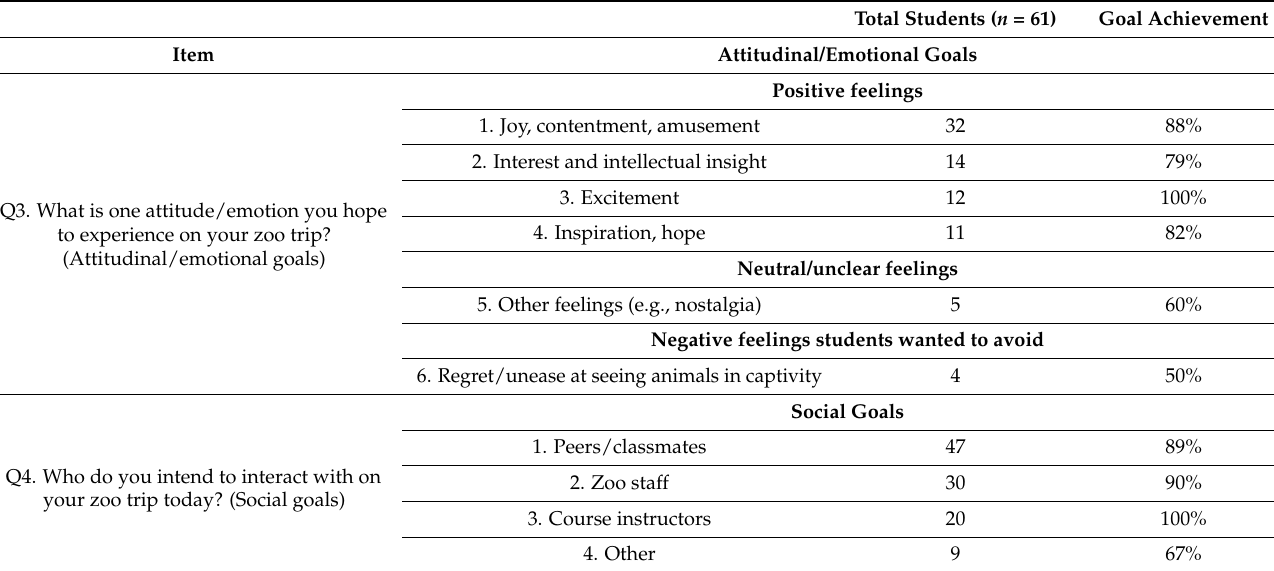
Table 3. Emerging themes for Questions 3 and 4 on the survey, number of students citing each theme, and percent goal achievement for each theme. Neither attitudinal/emotional goals nor social goals were coded into mutually exclusive themes, as both responses for both goal types could be dual-coded into two or more themes. Further, as the negative feelings coded for Q3 were intended to be avoided by students on their zoo trip, the “goal achievement” percent here represents how many students avoided the negative feelings they originally expressed on the pre-survey. Total Students ( n = 61) Goal